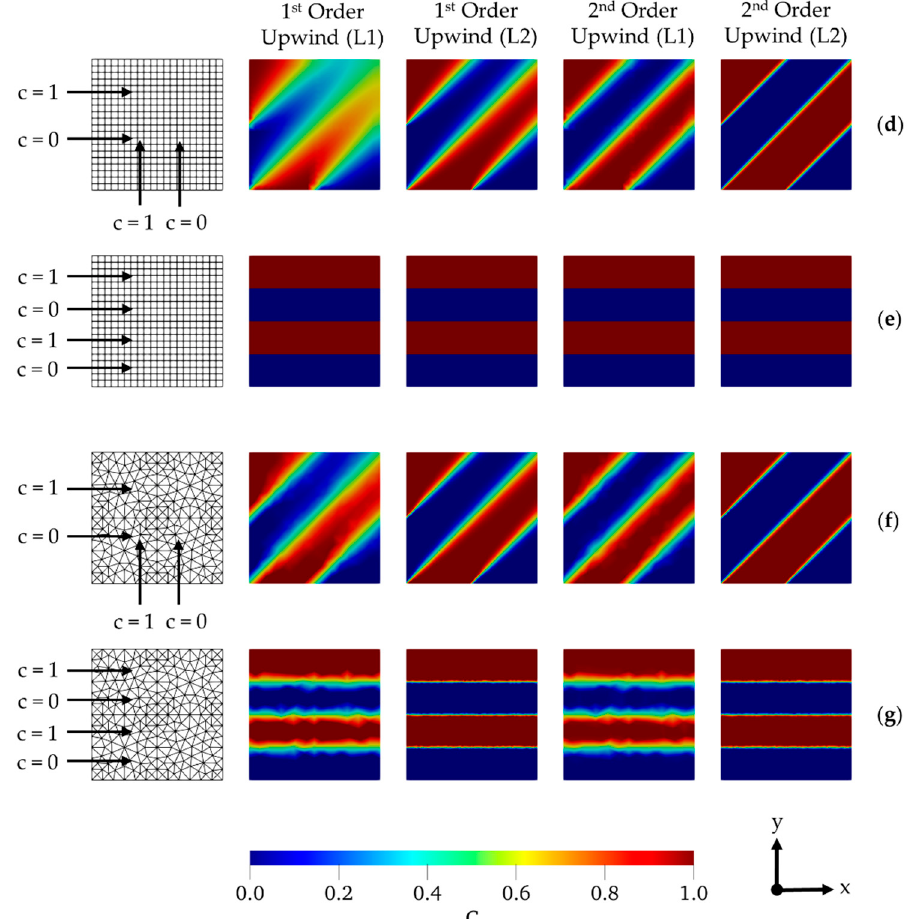
Figure 2. Extended 2-D test case for multi-inlet scenarios: ( d ) square elements with 45 ◦ flow angle; ( e ) square elements with 90 ◦ flow angle; ( f ) and ( g ) triangular elements with randomly changing flow-boundary angle with imposed flow fields ( u , v ) = (0.01 m/s, 0.01 m/s) and (0.01 m/s, 0) respectively.